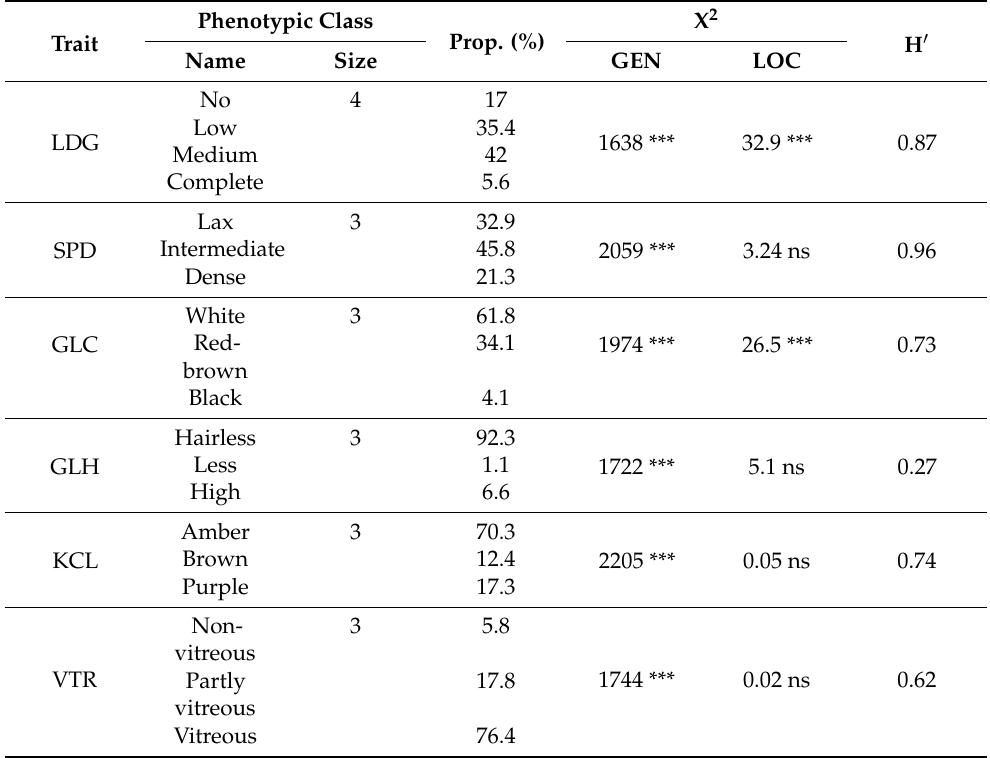
Table 3. Summary of chi-square (X 2 ) test and Shannon diversity index (H (cid:48) ) for six qualitative traits analyzed based on data collected from 420 durum wheat genotypes grown at two locations. Phenotypic Class X 2 Prop. (%) Trait H (cid:48) Name